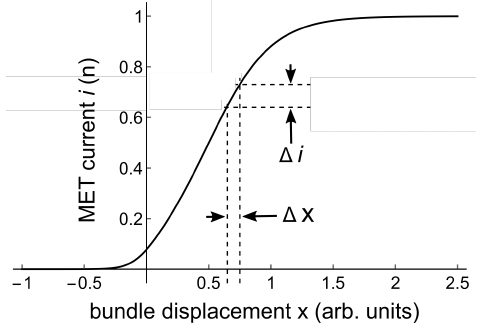
Figure 3. Solid line: MET-curve for parameters a = 1, x 1 = − 0.05, x 2 = 0.5, α 1 = 10, α 2 = 4. A small bundle displacement ∆ x creates a small MET current change ∆ i